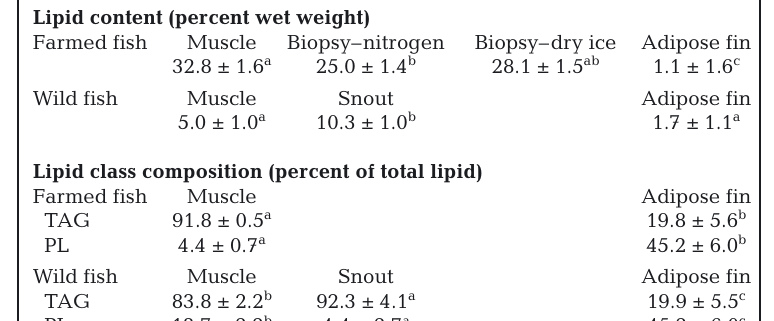
Table 1. Salmo salar. Lipid content and lipid class composition of the fish collected in Samplings 1 (farmed salmon) and 2 (wild salmon). Lipid contents are shown as means (±SEM). Potential differences between the tissues were assessed by 1-way ANOVA. Significance was accepted at p < 0.05. Numbers within each line not sharing common superscript letters are significantly different. Lipid class compo- sition is the mean of 5 fish. Farmed fish: maturing fish at Matre Research Station, n = 15; wild fish: wild fish returning to the Dale River for spawning, n = 9; biopsy– nitrogen, biopsy–dry ice: muscle biopsies frozen immediately after sampling